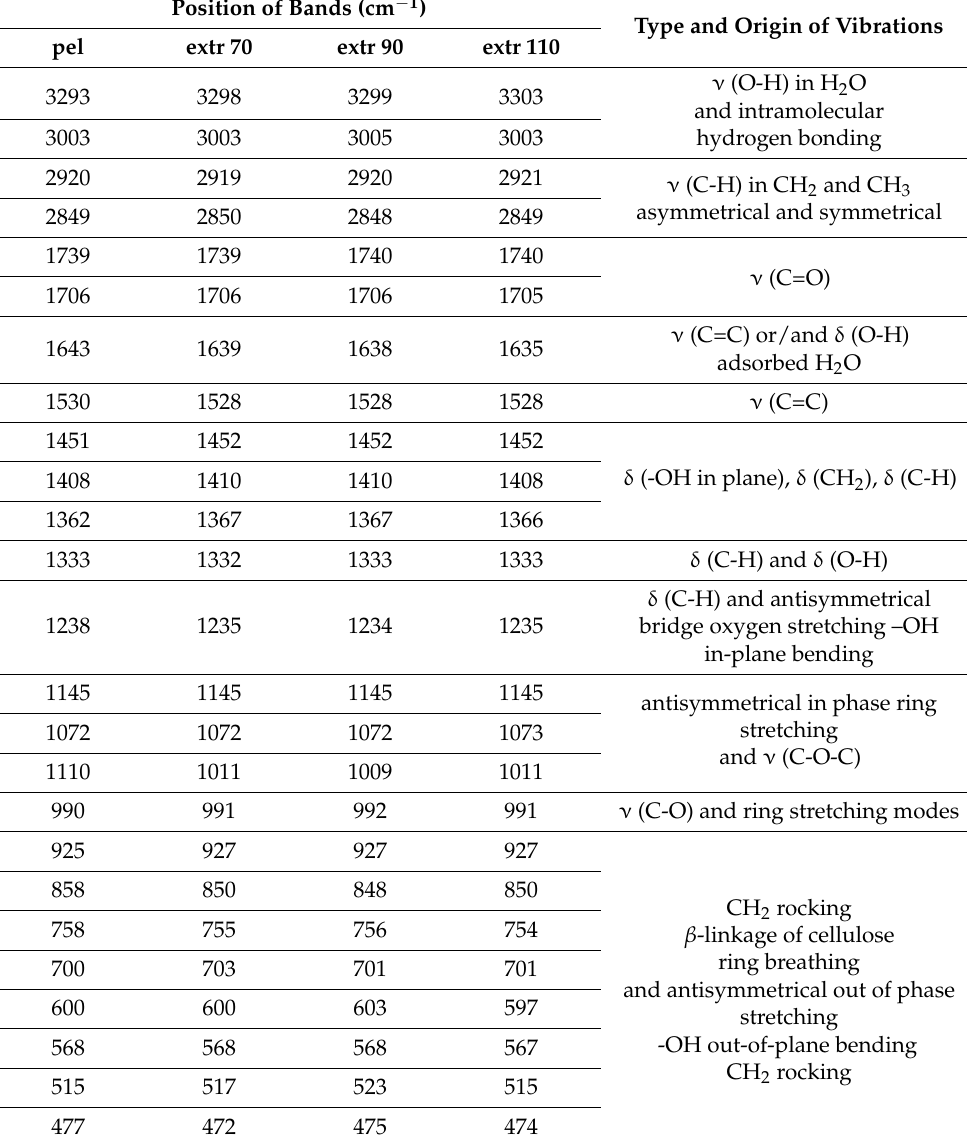
Table 5. The location of the maxima of absorption bands ATR-FTIR with arrangement of appropriate vibration for selected sampling made in terms of spectra 3750–400 cm − 1 . The results were obtained at room temperature and